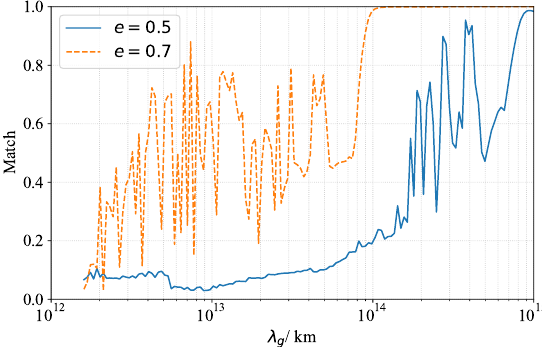
Figure 4. Matches between dispersive and nondispersive GW series in different e and λ The curves begin at λ g = 1.6 × 10 12 km, the total masses of the systems are M = 500 M (cid:12) , where the symmetric mass ratio ν = 10 − 2 , e = 0.5 (cyan line) and e = 0.7 (orange line), p = 12 M , and a = 0.95. For the GW series, the duration is 2 7 s (128 s) and the sampling frequency is 2 14 Hz. We set D L = 1.00 Gpc, where Z ≈ 0.20 and D ≈ 0.83